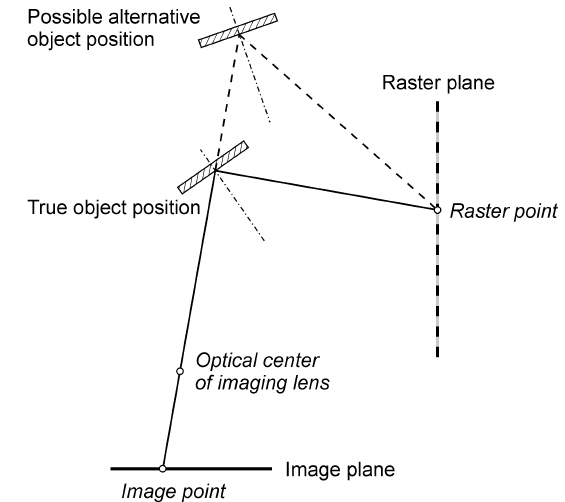
Figure 3. Setup for deflectometric measurements according to the enhanced approach shown in Fig. 2 (Petz,